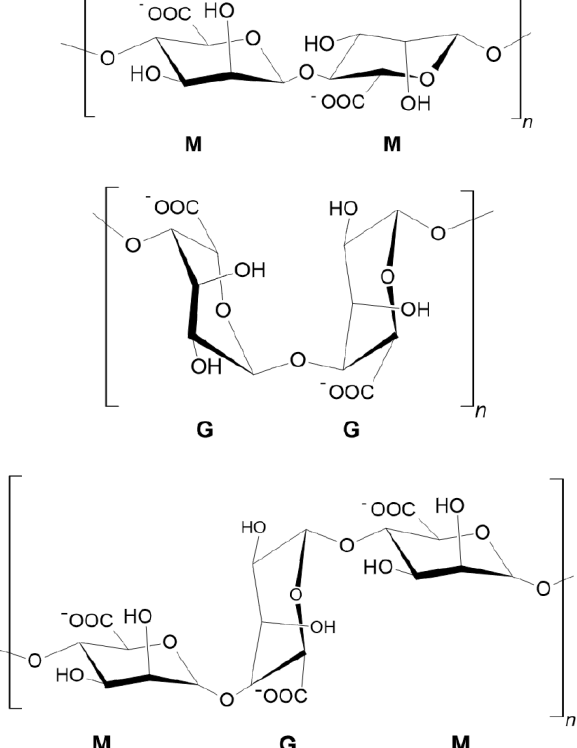
Figure 5. Chemical structures of mannuronic acids diads (MM), guluronic acid diads (GG), and alternated mannuronic acid/guluronic acid/mannuronic acid triad (MGM) in alginate.